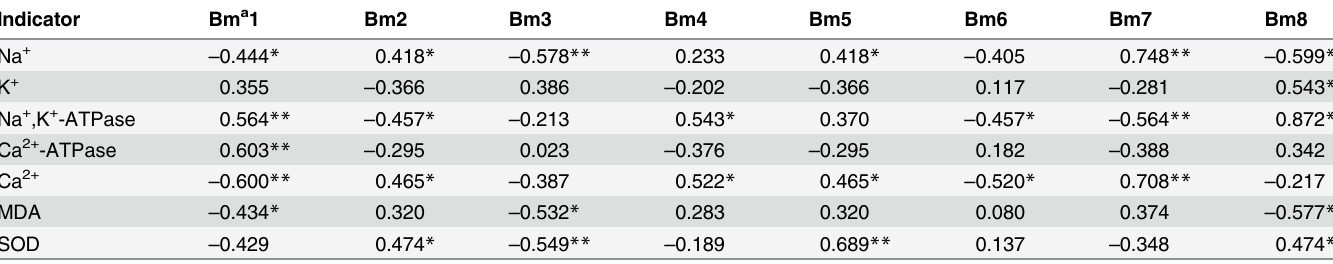
Table 5. Correlative analysis of biomarkers and biochemical data in hippocampal tissue.